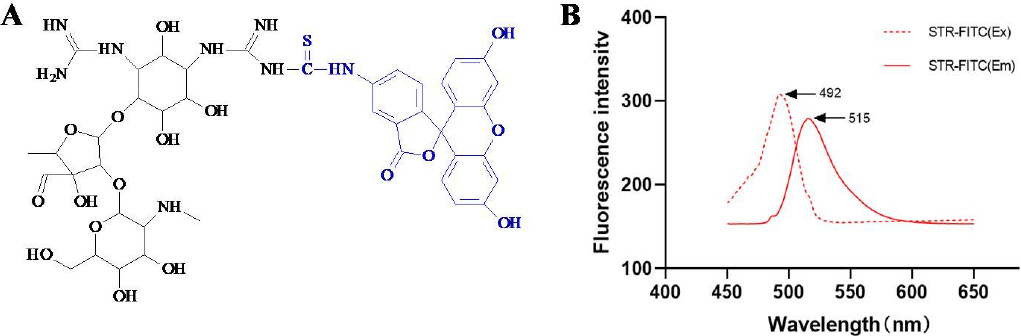
Figure 2. ( A ) Molecule of STR-FITC and ( B ) its fluorescence spectrum. STR-FITC is the conjugate of streptomycin (STR) and fluorescein isothiocyanate (FITC). STR-FITC (Ex) is the excitation wavelength of STR-FITC, and STR-FITC (Em) is emission wavelength of STR-FITC.